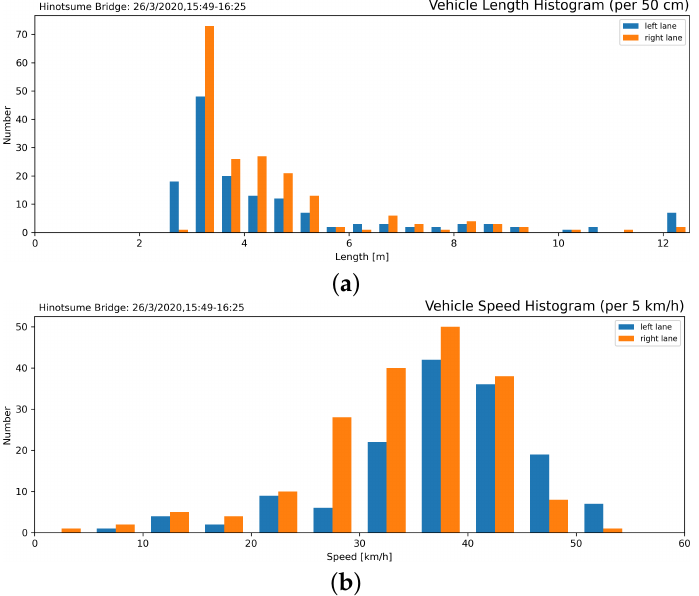
Figure 11. Length of detected vehicles in both lanes on the bridge ( a ). The length was evaluated from the passing vehicles’ pixelwise width in the frame, using different scaling factors for each lane as the left-going is closer to the camera: 36.55 mm/px (left-going) and 38.38 mm/px (right-going). The speed of detected vehicles ( b ) was evaluated from the distance traveled and its duration from a particular ID.